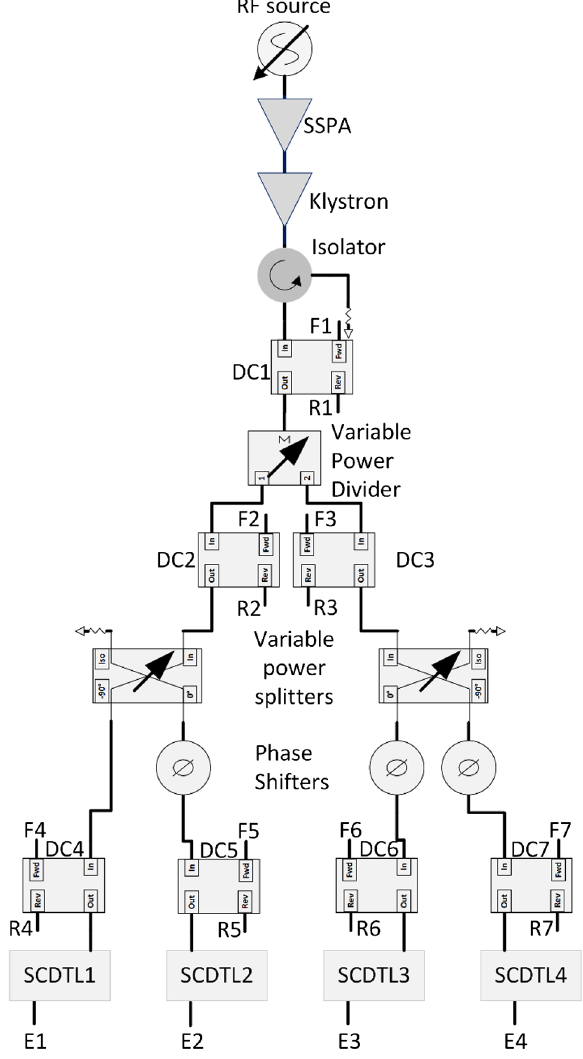
FIG. 11. The rf power system distribution